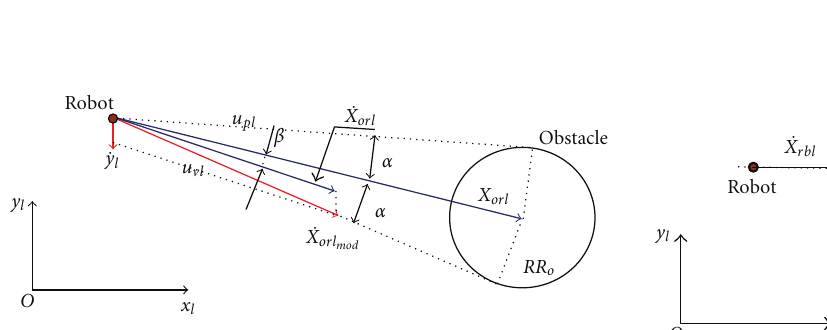
Figure 8: Basic concept of moving obstacle avoidance.